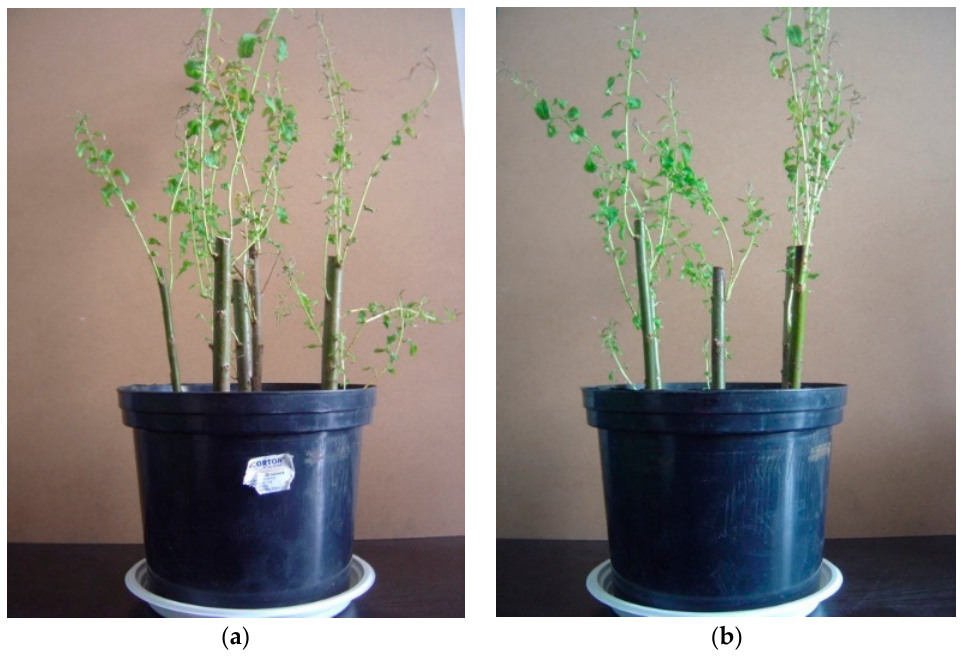
Figure 3. Cultivation of energetic willow: ( a ) fertilized with prednisonum, ( b ) without pred-